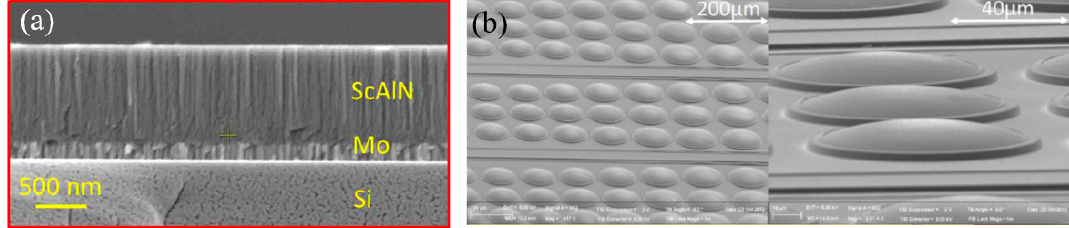
Figure 22. ( a ) SEM image of the sputtered Sc doped AlN film (Reproduced with permission from IEEE [144]). ( b ). SEM images of the Nb-doped PZT (PNZT)-based pMUT array showing dome-shaped elements with different dimensions (Reproduced with permission from AIP [146]).